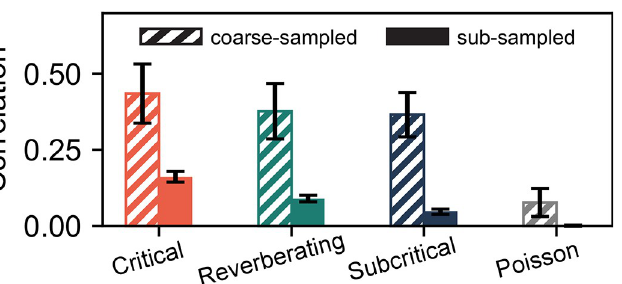
Fig 3. Coarse-sampling leads to greater correlations than sub-sampling. Pearson correlation coefficient between the signals of two adjacent electrodes for the different dynamic states. Even for independent (uncorrelated) Poisson activity, measured correlations under coarse-sampling are non-zero. Parameters : Electrode contribution γ = 1, inter- electrode distance d E = 400 μ m and time-bin size Δ t = 8